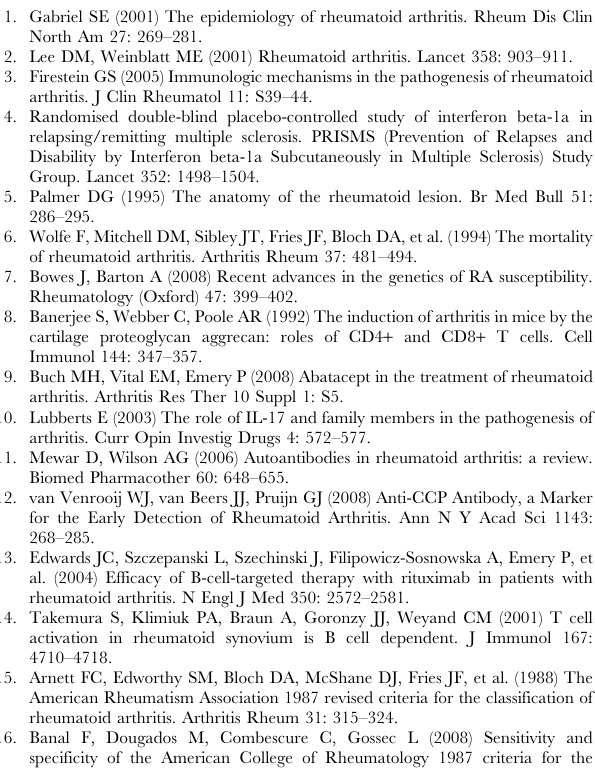
Figure S9 Methotrexate therapy decreases phospho-signaling in ERA PBMCs. PB MFI values for each of the indicated phospho- epitopes are plotted to compare ERA patients on MTX (no LEF or systemic steroids) (n= 15 except for p-JNK, p-p38 and p- STAT3 where n= 13 and p-AKT, p-BTK and p-H3 where n= 8; open circles) versus those not (n= 12 except for p-AKT, p-BTK and p-H3 where n= 9; closed circles). Data are shown for each of the indicated cell populations. Significant differences were calculated by Student’s t test (p , 0.05). Table S1 Patient medication DOC) Table S2 Staining panel for phospho-specific profiling of PB leukocyte subsets. Phospho-specific stains are shown in